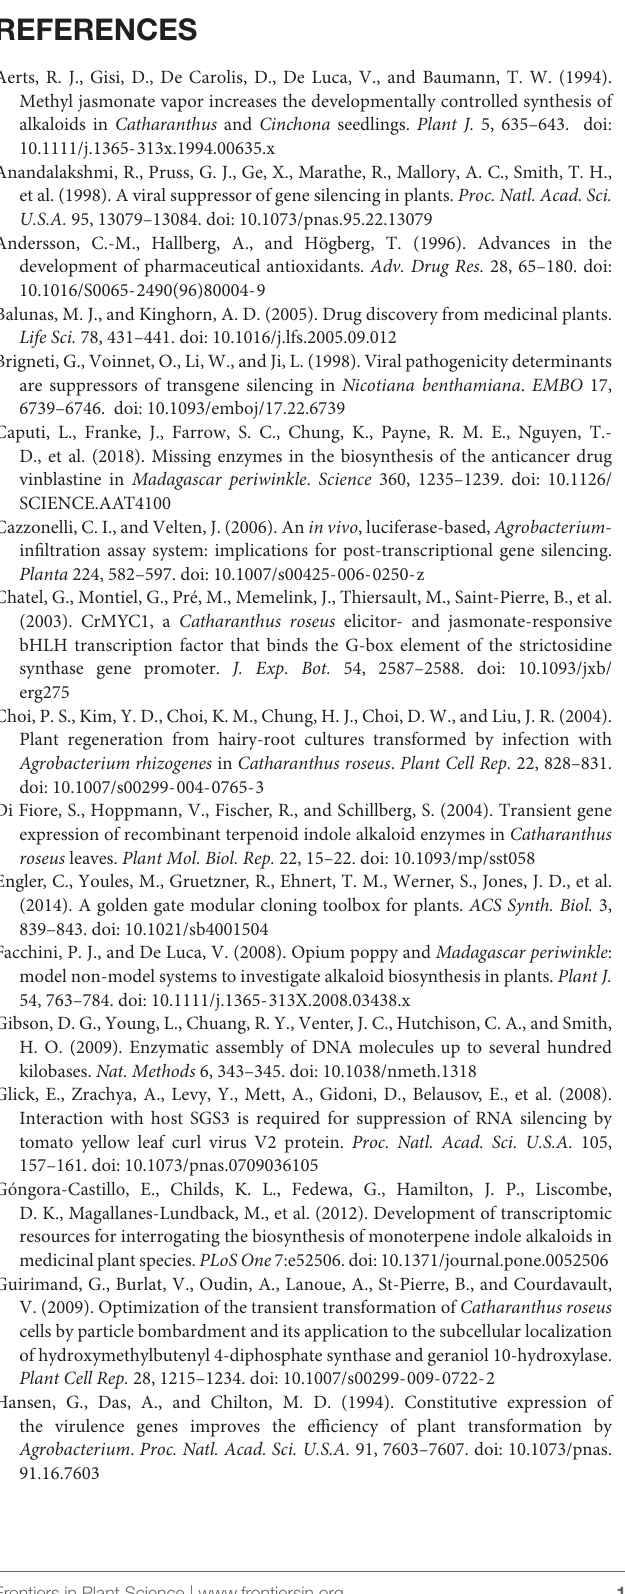
TABLE S1 | Primers used for the construction of new vectors. TABLE S2 | Construction of level 0 vector